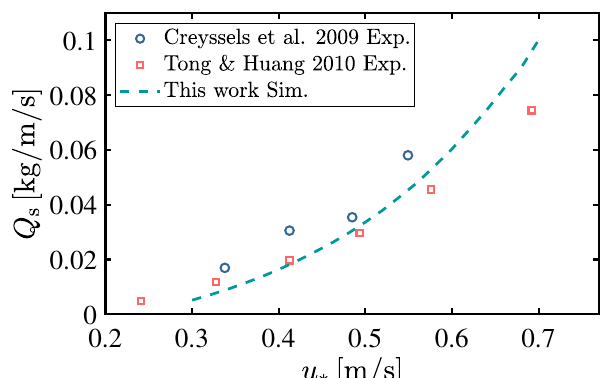
Figure 3. Comparison of the relationships between sand transport rate and the friction velocity calculated in this paper with that from experiments by Creyssels et al. [72] and Tong and Huang